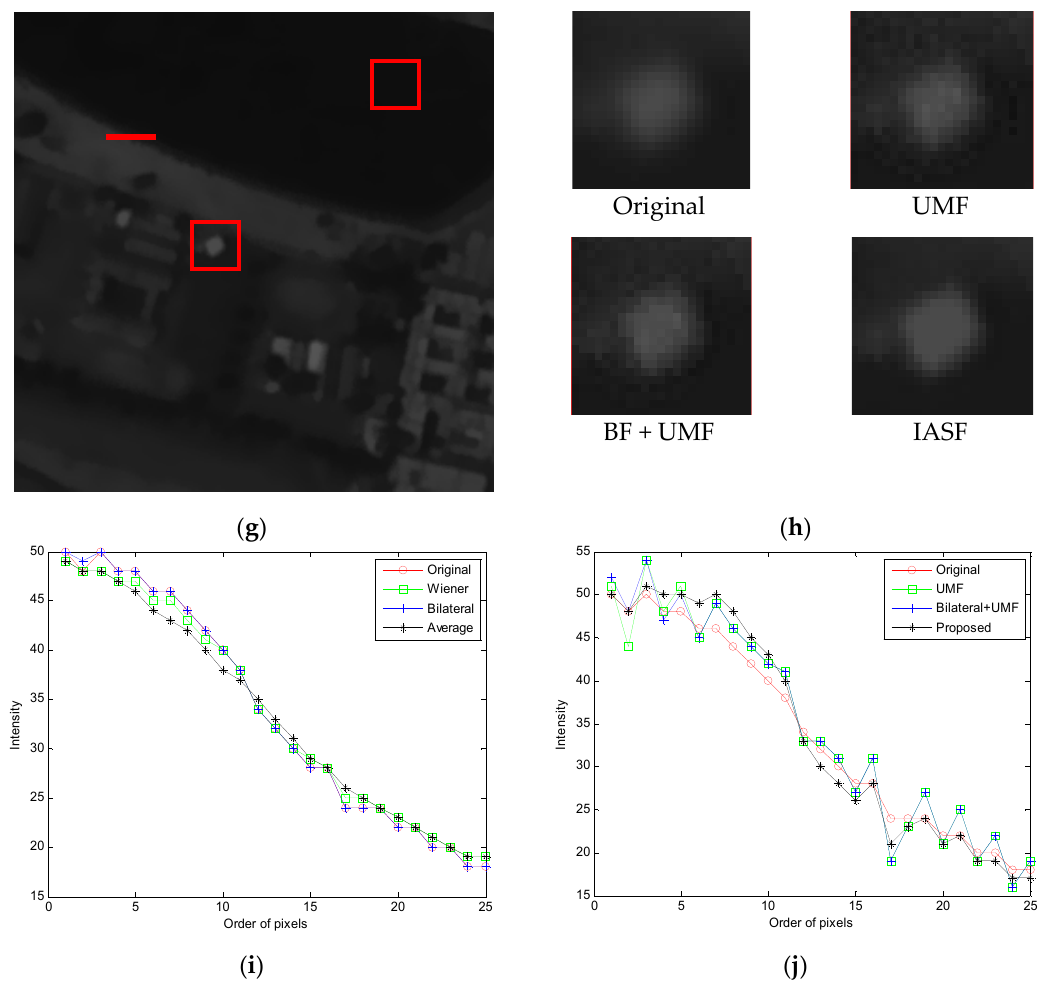
Figure 4. The raw image data of target 2 and its processed resultant images by different filters: ( a ) original data; ( b ) WF; ( c ) AF; ( d ) BF; ( e ) UMF; ( f ) BF + UMF; ( g ) IASF; ( h ) zoomed in images of box B; ( i ) gray level distributions of edge C for ( a – d ); ( j ) gray level distributions of edge C for ( e – g ).